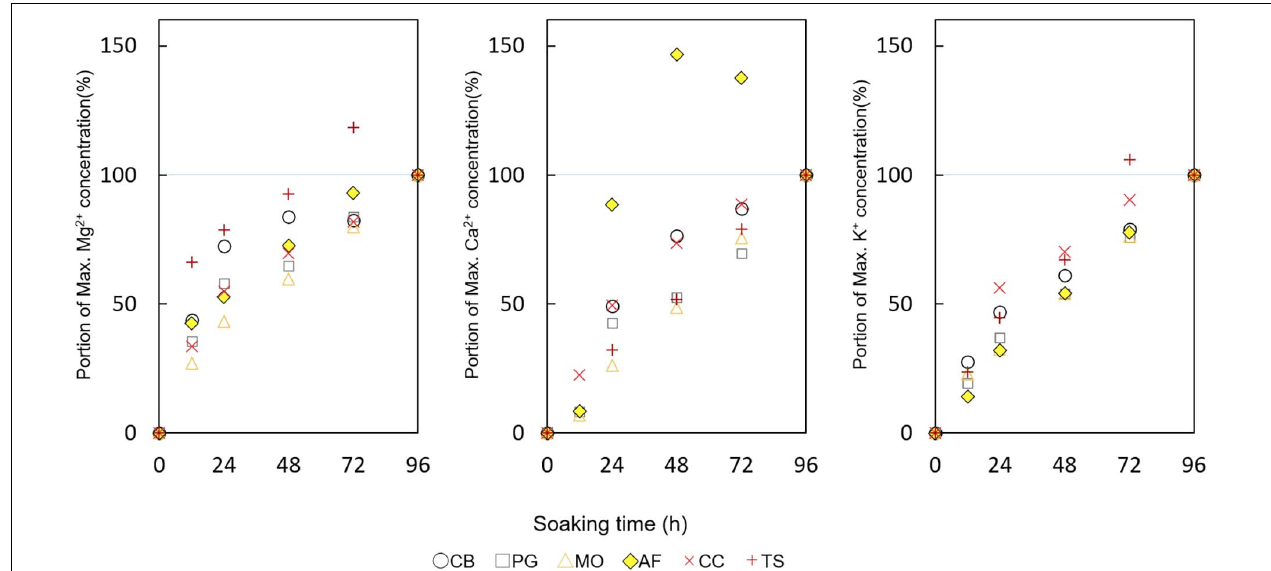
FIGURE 4 | The portions of maximum Mg 2 + , Ca 2 + , and K + concentration (%) by soaking time (hr). Colors mean each species as CB Clethra barbinervis (white circle), PG as Padus grayana (gray square), MO as Magnolia obovata (orange triangle), AF as Abies firma (yellow diamond), CC as Castanea crenata (light red x), and TS as Tsuga sieboldii (deep red